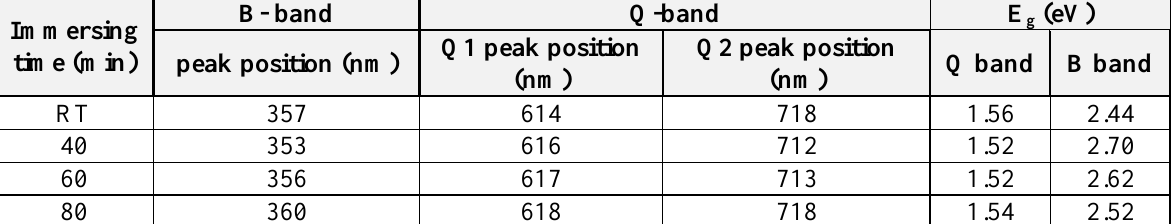
Table 6: Bands position and the optical energy gaps of CuPcTs/PEDOT:PSS thin films chemically treated with Chloroform with different time.